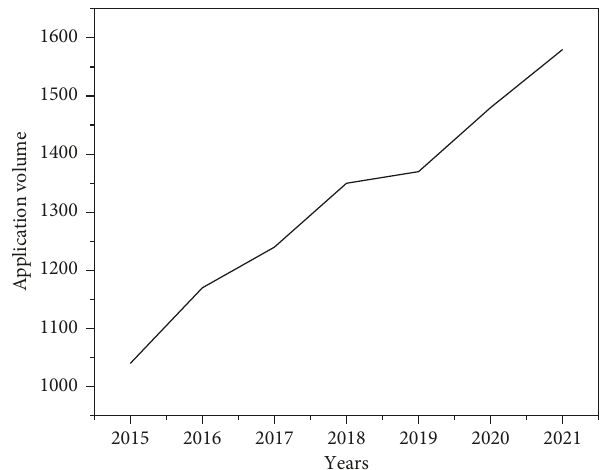
Figure 4: Application of green building